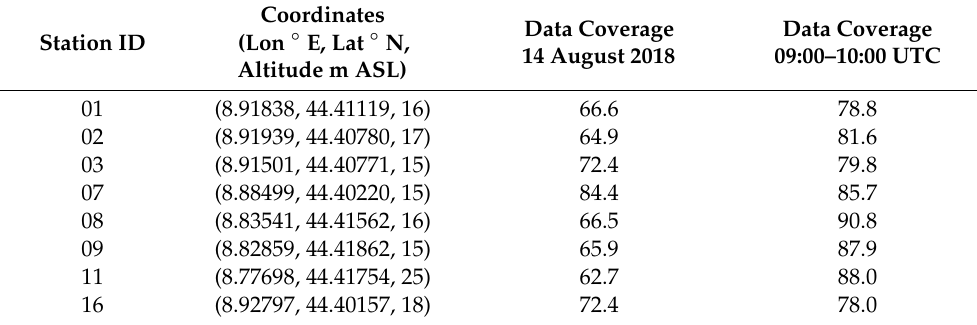
Table 2. Specification of the anemometric stations managed by the Port Authority of Genoa.